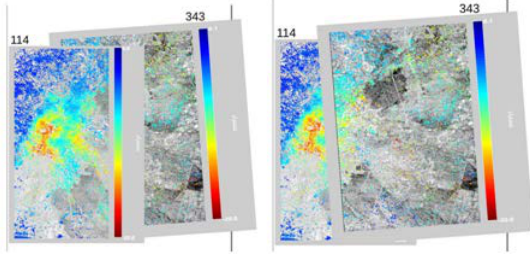
Figure 4. StaMPS PS InSAR results for tracks 343 and 114 (Çomut, et.al., 2015)